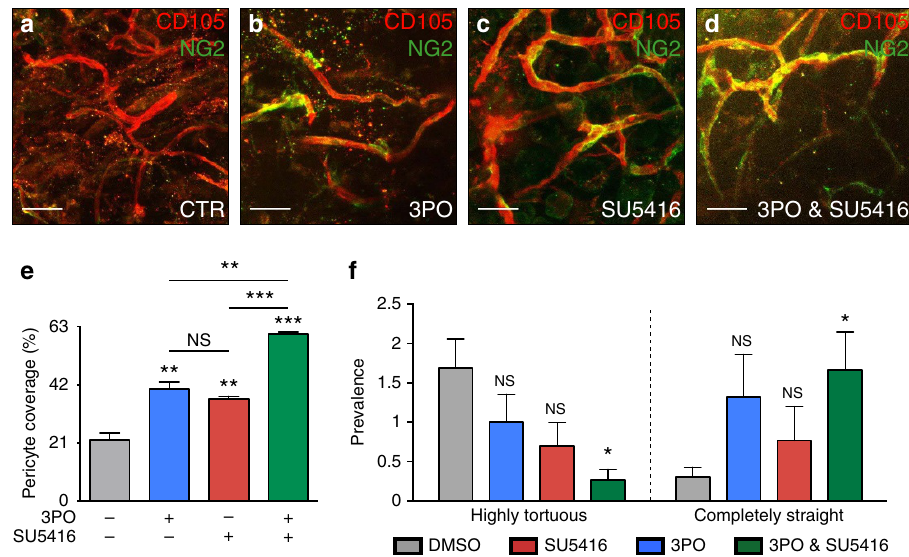
Figure 7 | 3PO plus SU5416 combo-therapy normalizes pathological vessels. ( a–d ) Representative images of VEGF-containing Matrigel plugs treated with control vehicle ( a ), the PFKFB3 blocker 3PO ( b ), the VEGFR2 inhibitor SU5416 ( c ), and a combination treatment of 3PO plus SU5416 ( d ), and immunostained for the EC marker CD105 (red) and the pericyte marker NG2 (green). Scale bar, 40 m m. ( e ) Quantification of the NG2-coverage of vessels in the Matrigel model, treated with control vehicle (DMSO, grey), 3PO (blue), SU5416 (red), or 3PO plus SU5416 (green). Data are mean ± s.e.m.; n ¼ 3–5 Matrigel plugs per condition; NS: not significant, ** P o 0.01, *** P o 0.001; Student’s t -test. ( f ) Blood vessel tortuosity in the Matrigel model, treated with control vehicle (DMSO, grey), 3PO (blue), SU5416 (red), or 3PO plus SU5416 (green), was analysed semi-quantitatively by an observer blinded for the conditions. Data are mean ± s.e.m.; n ¼ 3–5 Matrigel plugs per condition; NS, not significant; * P o 0.05; Two-tailed Wilcoxon rank-sum test for equal medians. effective in normalizing EC behaviour (Fig. 6a–d; Supplementary Fig. 7a, Supplementary Movies 12,13). A full rescue with the inhibitor (SU5416) in physiological conditions 6 , we assessed in silico whether blockade of both PFKFB3 and VEGF signalling combined treatment was observed when the VEGFR2 signalling might be more efficient in normalizing the deregulated EC activity was decreased sixfold. Applying anti-VEGF therapy alone rearrangement in pathological conditions (10 (cid:2) VEGF). Since in 10x VEGF levels was predicted to only partially normalize the SU5416 inhibits VEGFR2 phosphorylation 34 , we modelled the disorganized EC dynamics (Supplementary Fig. 7b-e). Hence, anti-VEGF therapy by reducing VEGFR2 signalling activity the simulations predicted that combinatorial anti-glycolytic and (Supplementary Note). This simulation predicted that an anti-VEGF treatment would normalize EC rearrangement in anti-VEGF and anti-glycolytic treatment together were most disease. NATURE COMMUNICATIONS|7:12240|DOI: